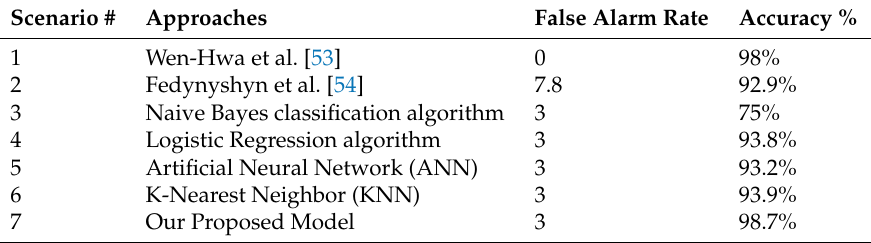
Table 5. Comparison with other published work and other machine learning